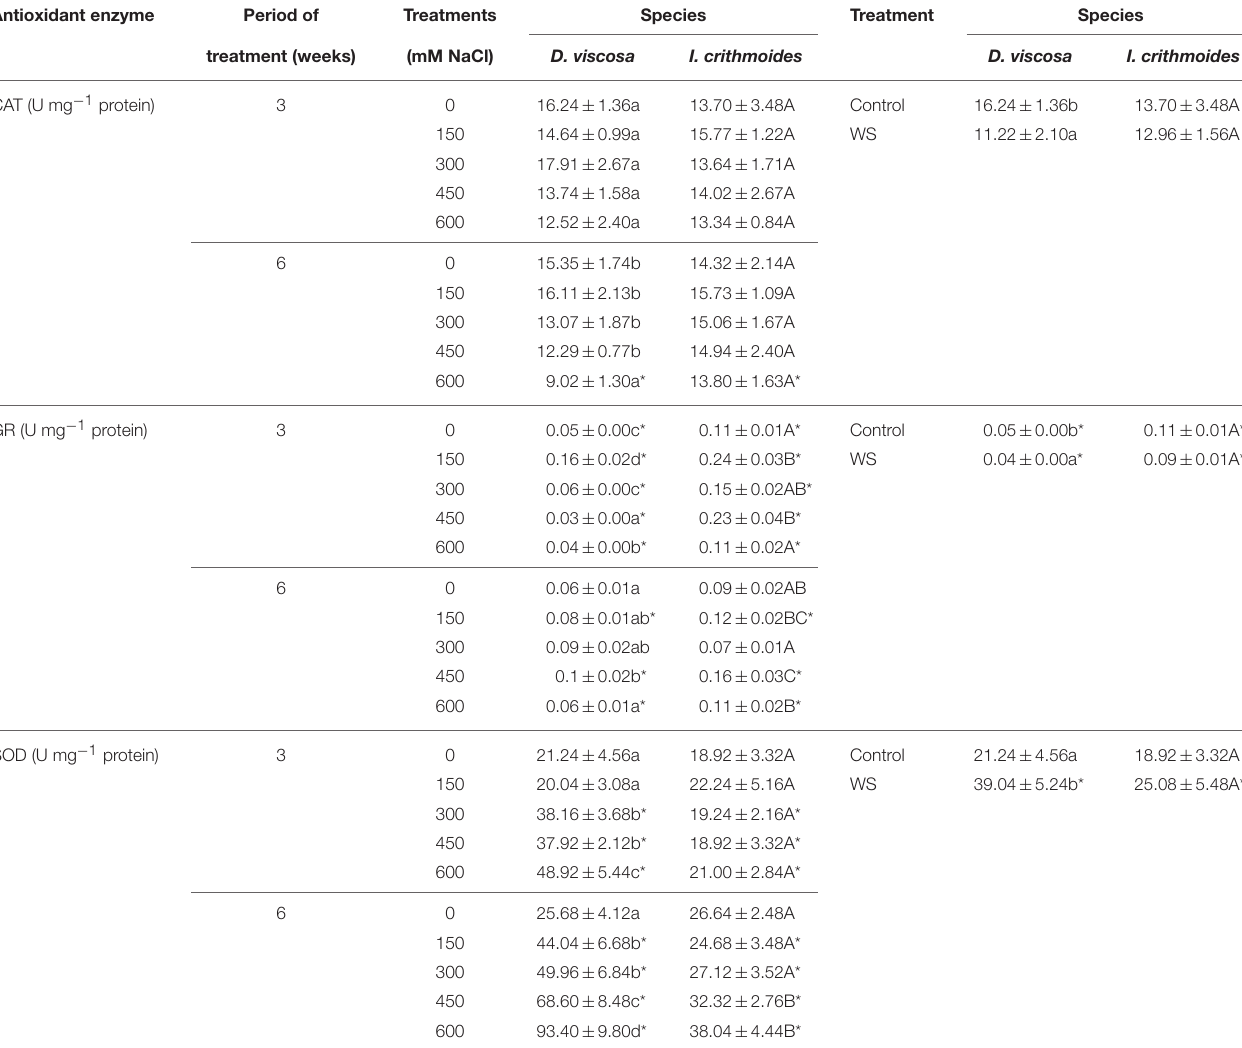
TABLE 4 | Antioxidant enzyme activities in leaves of salt-treated and water-stressed D. viscosa and I. crithmoides plants. Antioxidant enzyme Period